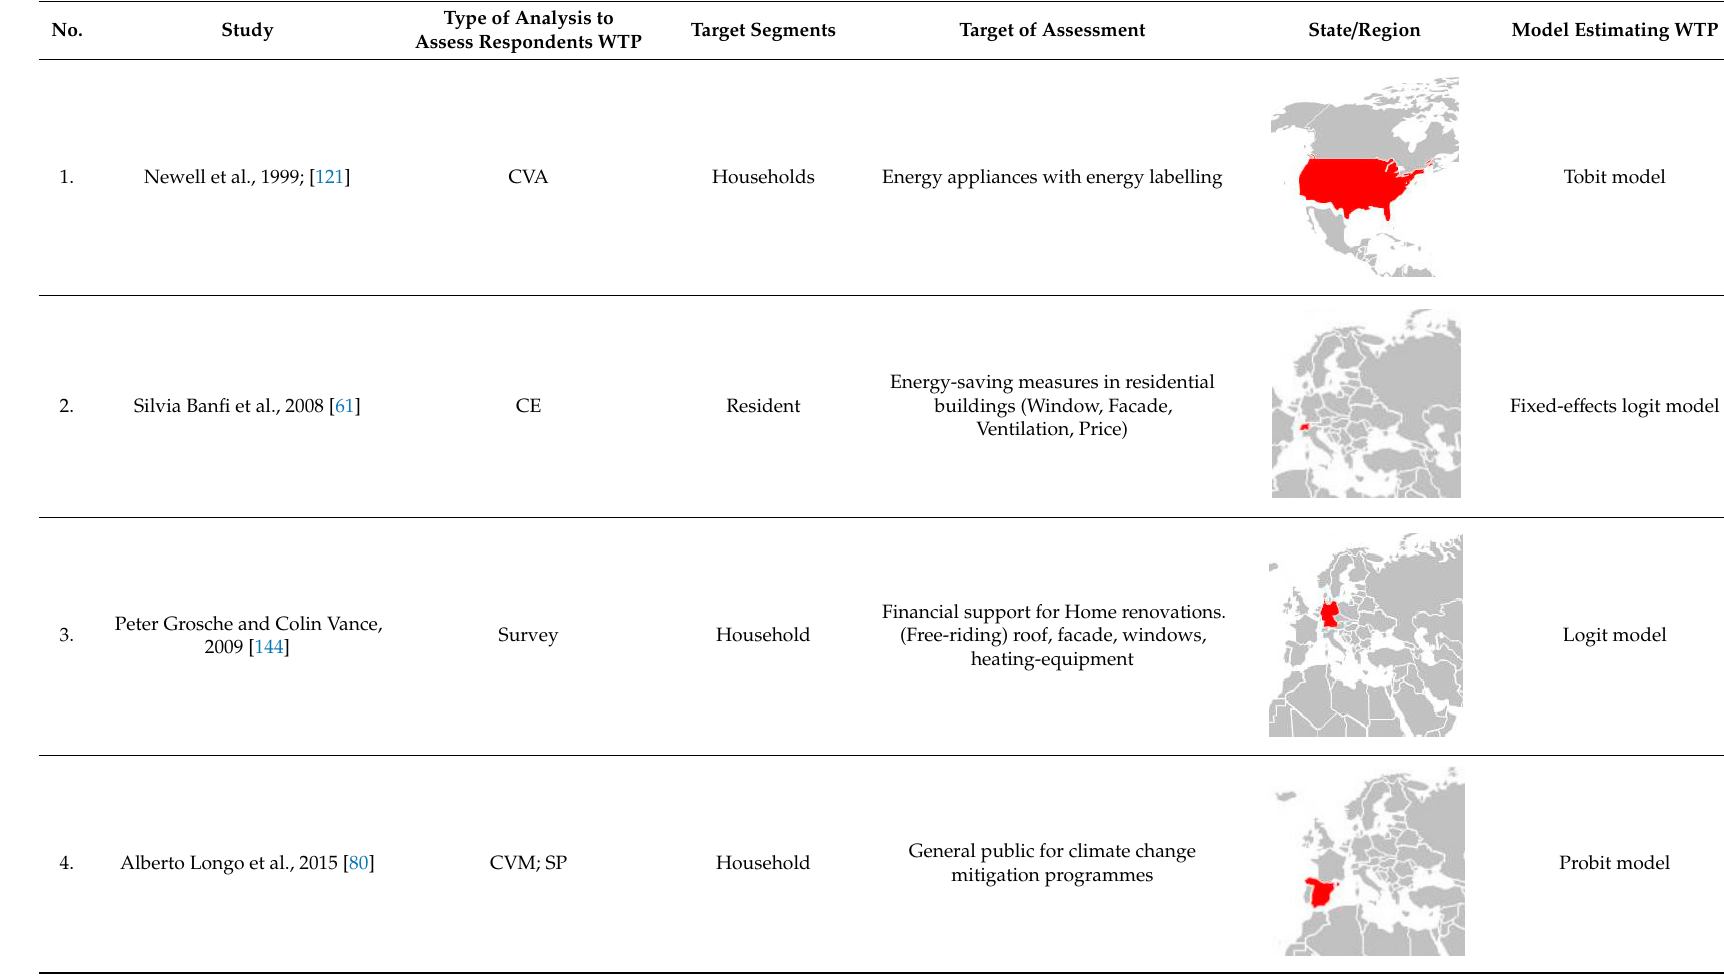
Table 4. Summary of WTP for renewables studies carried out with different types of analysis.